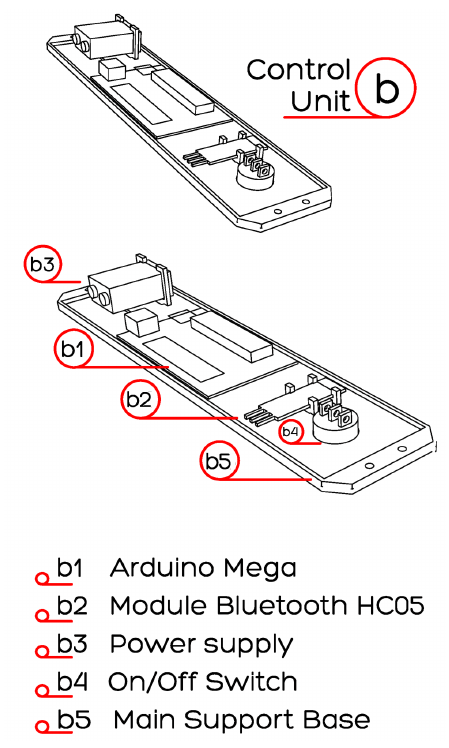
Figure 6. Control Unit